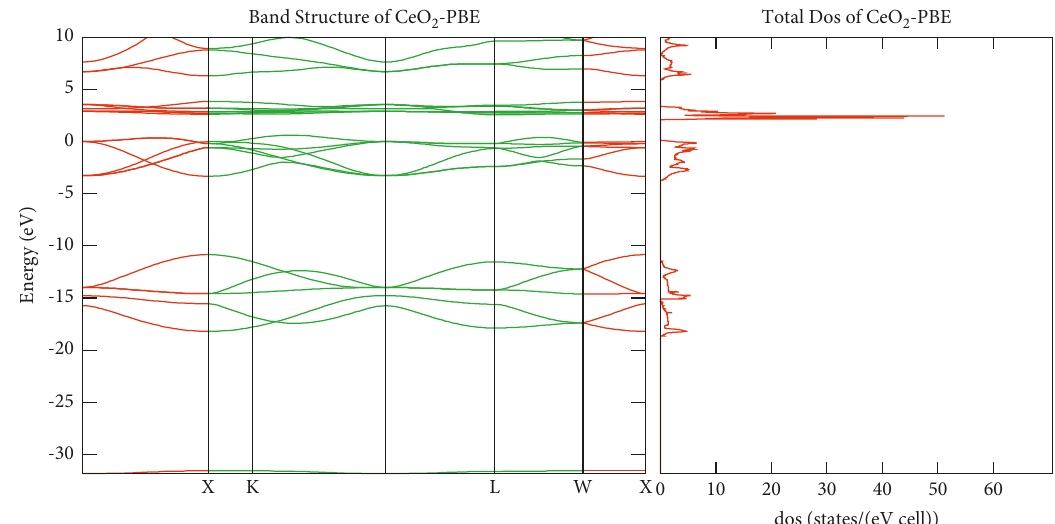
Figure 3: (a) Band structure of CeO 2 and (b) density of states of CeO 2 obtained with PBE